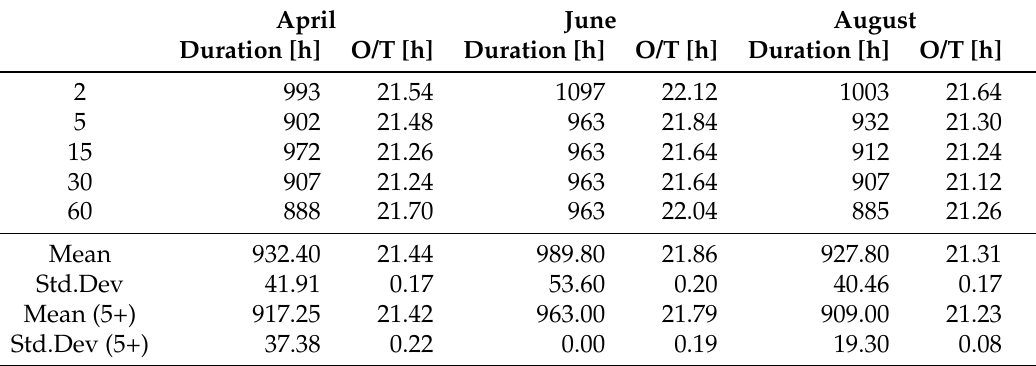
Table 8. Results of different optimization times for two